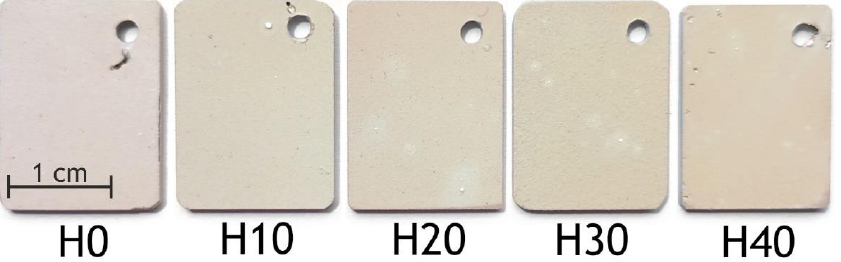
Figure 13. The appearance of H0, H10, H20, H30, H40 samples after 28 days of exposure to 3.5 wt.% NaCl solution. NaCl solution.